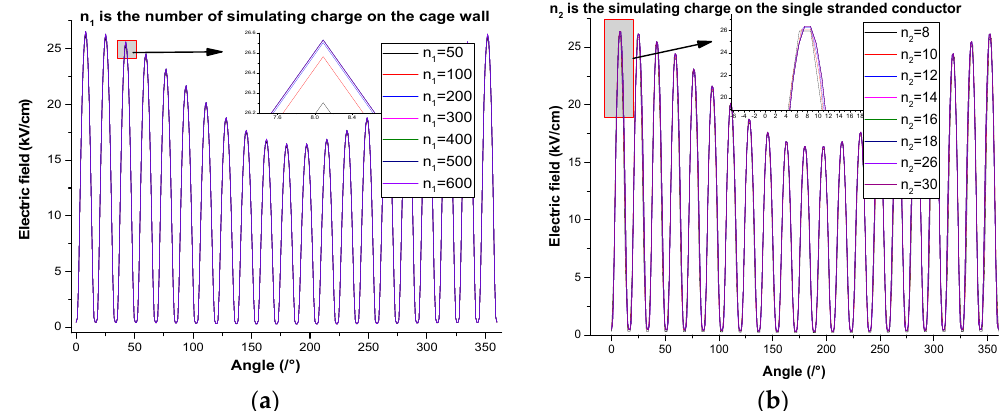
Figure 7. ( a ) Surface electric field on a stranded conductor with different numbers of simulated charges on the corona cage walls; ( b ) Surface electric field on a stranded conductor with different numbers of simulated charges on each single strand. Table 6. Computation error: change in electric field with number of charges on the corona cage. Number of Charges on the Corona Cage ( n 1 )